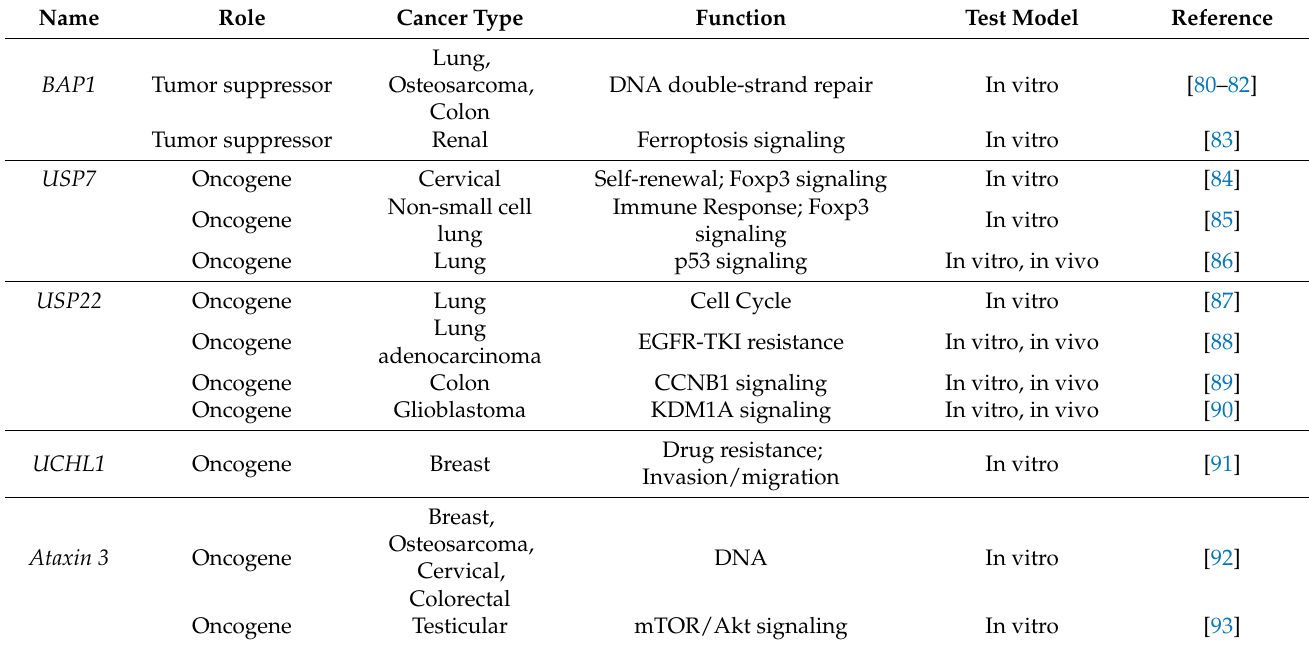
Table 2. Summary of the functions of DUB enzymes described in this